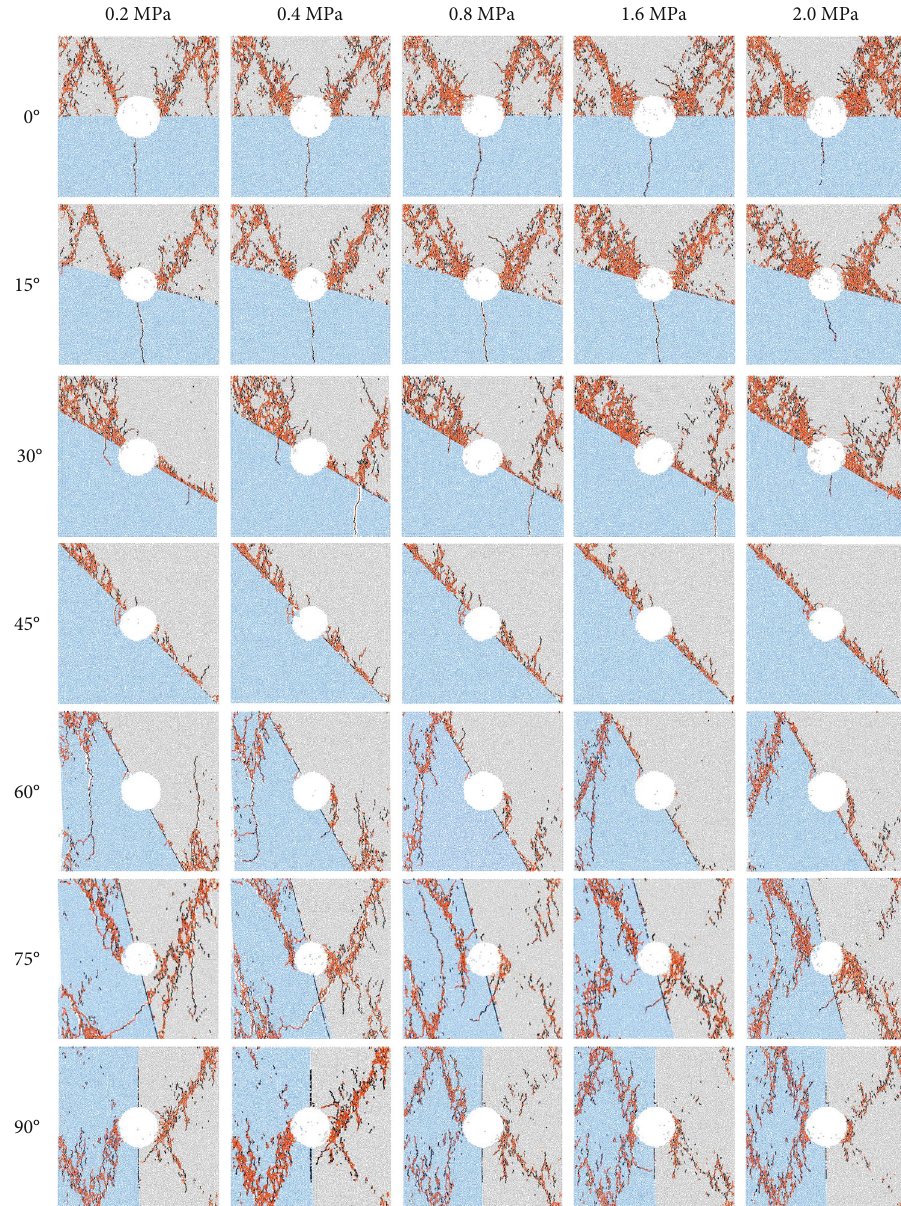
Figure 7: Failure mode of composite rock strata specimen with holes under di ff erent con fi ning pressures and di ff erent dip